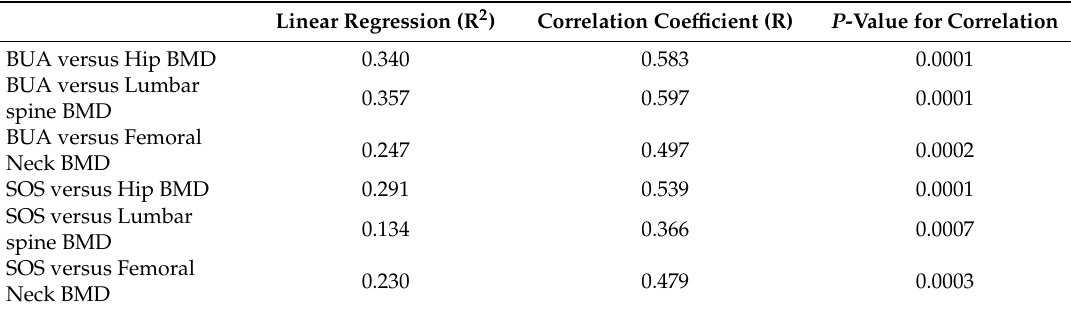
Table 4. Correlation between QUS and